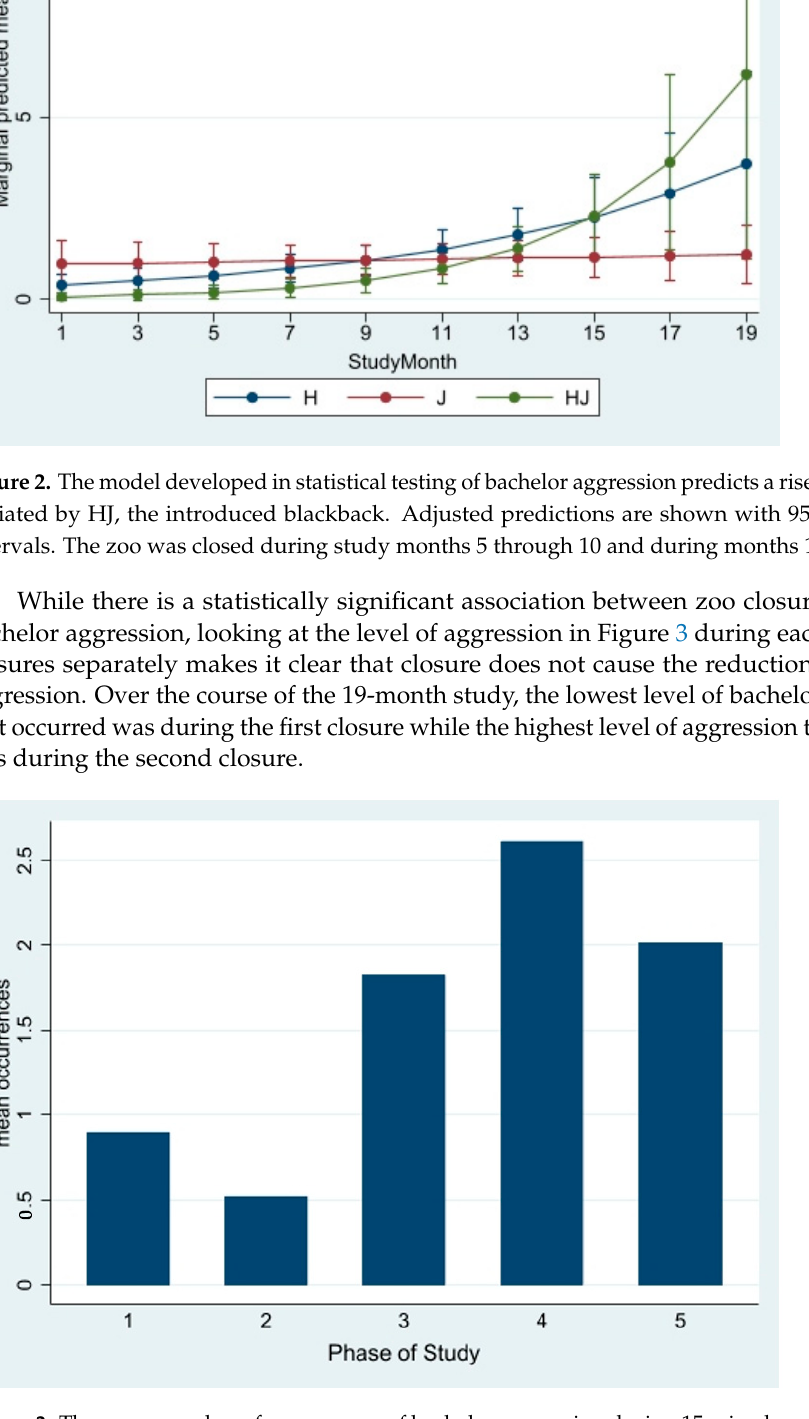
Figure 3. The mean number of occurrences of bachelor aggression during 15 min observation periods in each phase of the visitor study. The zoo was closed to visitors in phases 2 and